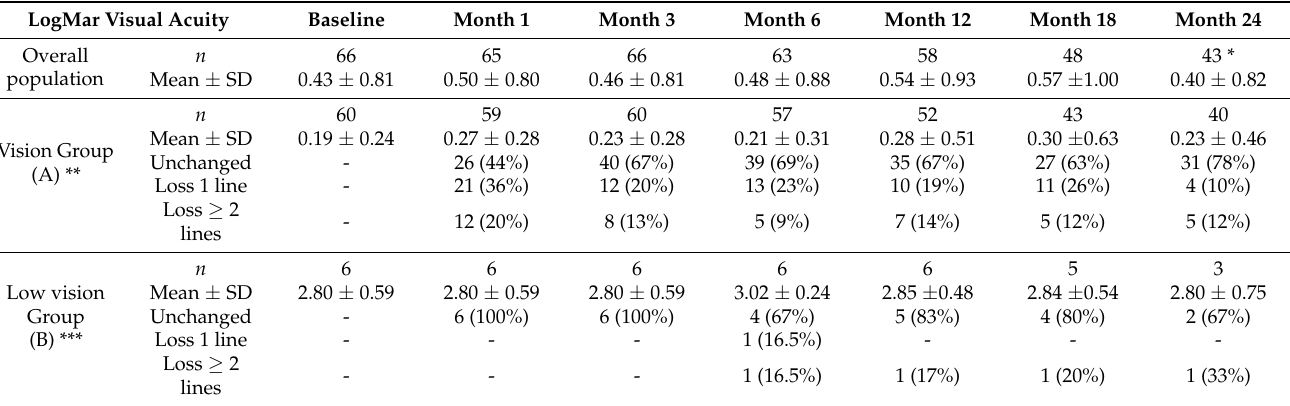
Table 4. Visual acuity at baseline and during